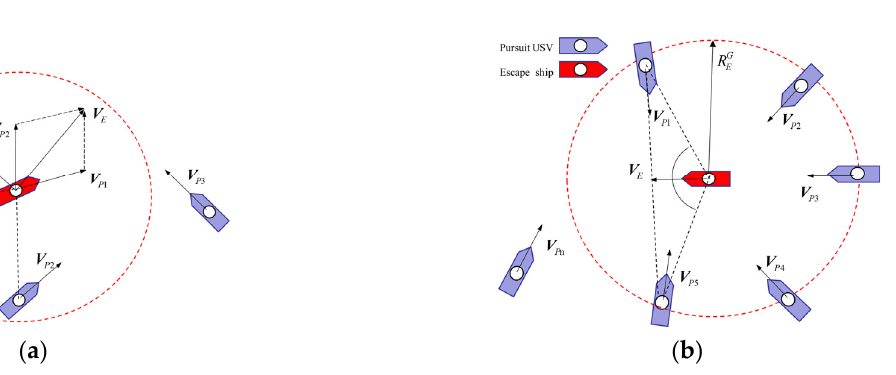
Figure 2. Evasion strategies under different situations. ( a ) Escape in the direction farthest away from the pursuers. ( b ) Escape in the maximum opening angle.